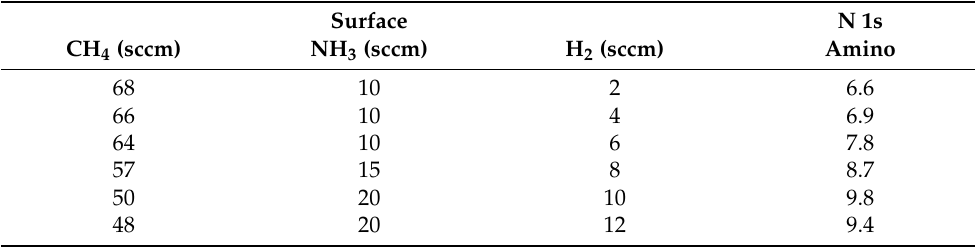
Table 4. Amino nitrogen (%) values quantified by XPS for surfaces plasma-coated with CH 4 /NH 3 /H 2 gas feeds (reported in columns named